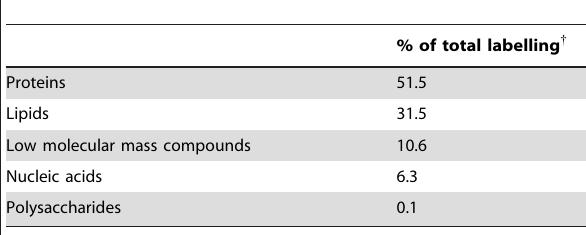
Table 2. Incorporation of [U- 14 C]acetate, in the presence of glucose, into cellular constituents of Z. bailii ISA 1307 growing in medium with glucose (2%, w/v) and acetic acid (0.2%, v/v) at pH 5.0.